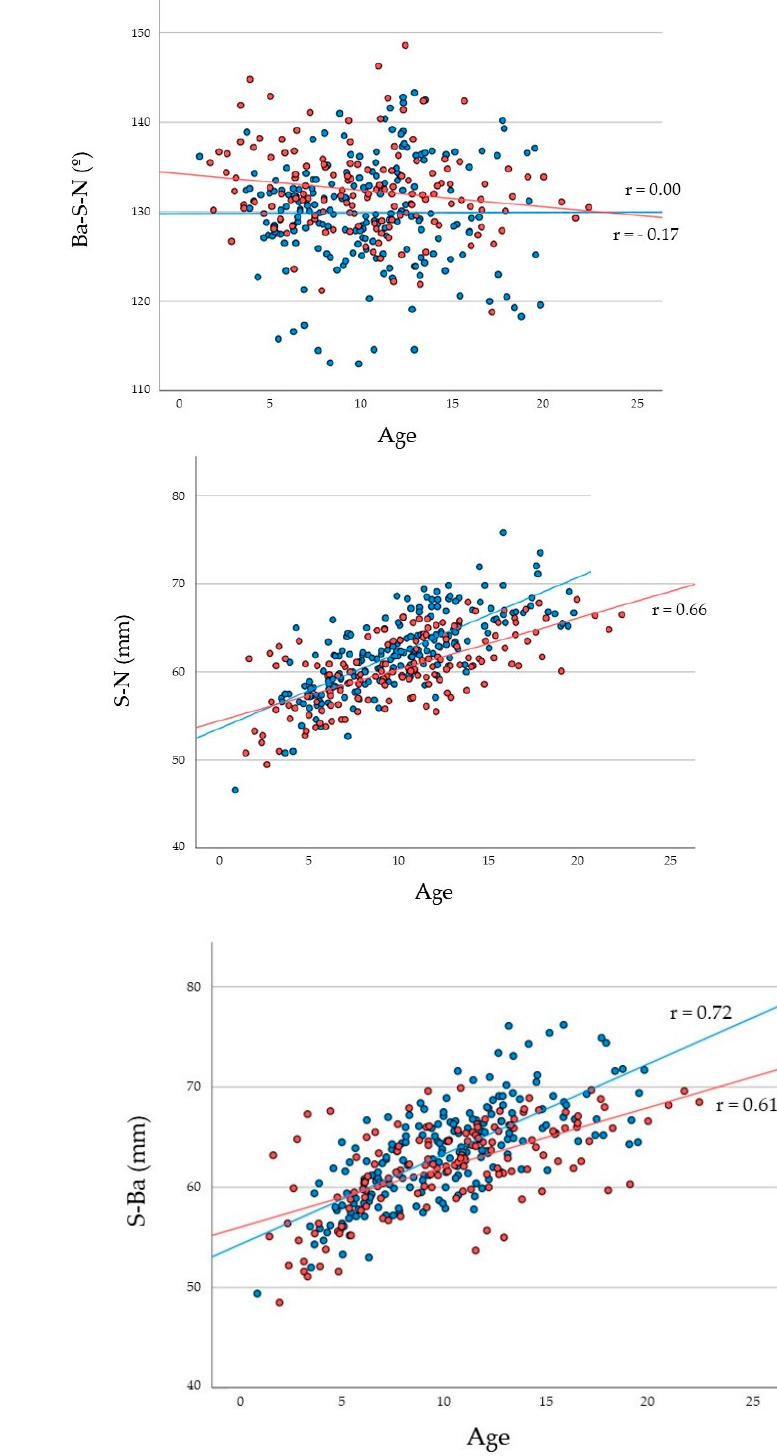
Figure 5. Scatter plots with linear single regression lines between the cranial base angle (Ba-S-N) and age ( a ); between the length of the anterior cranial base (S-N) and age ( b ); and between the length of the posterior cranial base and age ( c ) for each sex. Red plots and lines indicate females, while blue plots and lines indicate males.